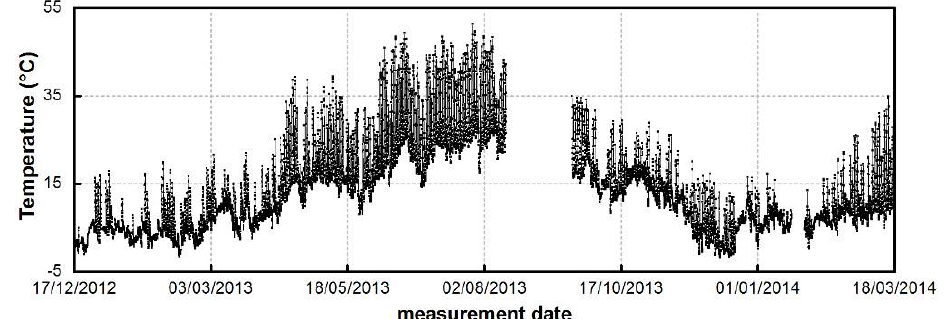
Figure 8. Time evolution of the temperature measured on the S ‐ W front of the tower from 17/12/2012 to 17/03/2014.